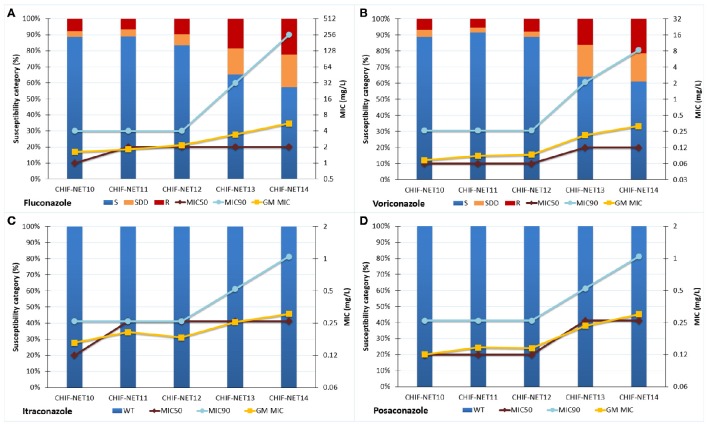
Trends of susceptibility (including susceptible or wild-type rate, and MIC50, MIC90, and GM MIC values) of 507 C. tropicalis isolates to four azoles (A), fluconazole; (B), voriconazole; (C), itraconazole; (D), posaconazole, over 5 years. S, susceptible; SDD, susceptible dose-dependent; R, resistant; WT, wild-type; NWT, non-wild-type; MIC, minimum inhibitory concentration; GM, geometric mean.